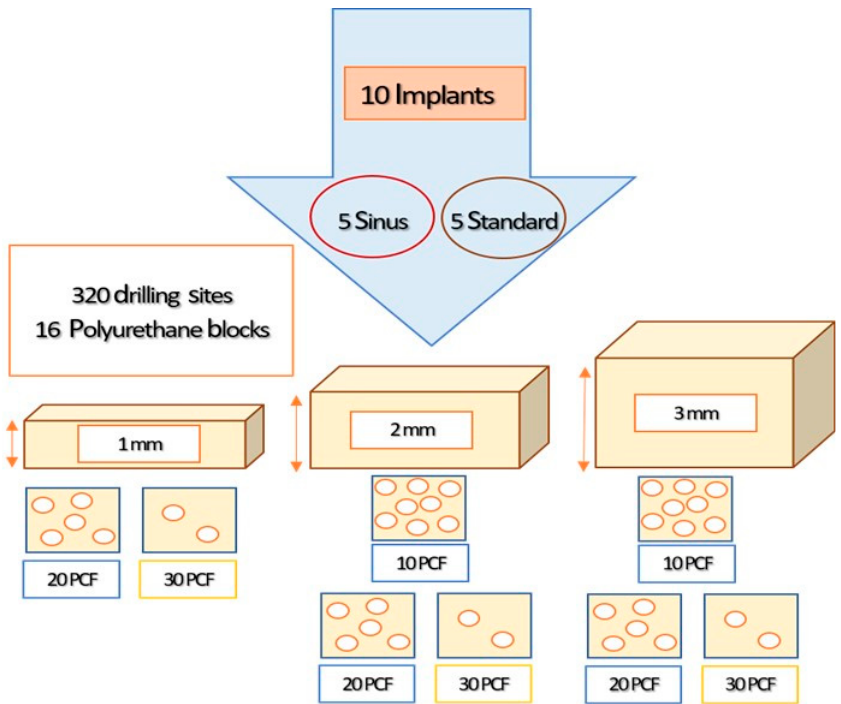
Figure 3. Summary of the study design. The test and control implant were tested in different poly- urethane